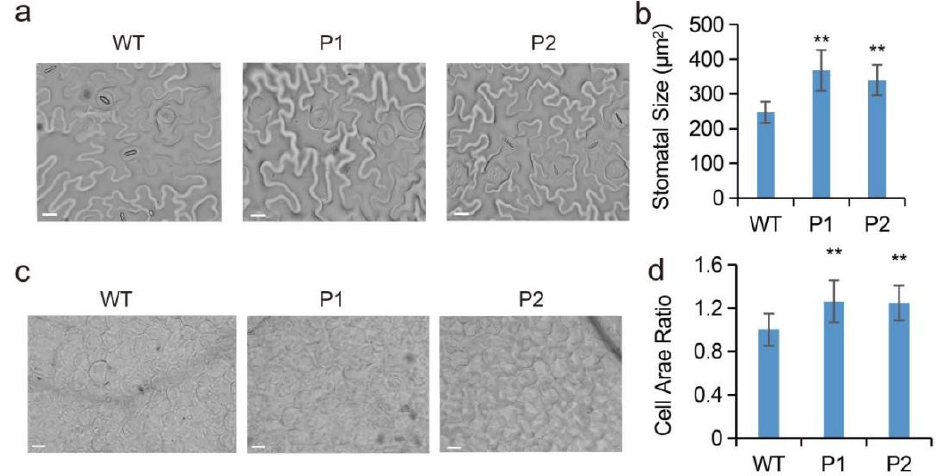
Figure 5. Effect of EuPIP1;1 on leaf cell size in Arabidopsis . ( a ) Stomata distribution in WT and transgenic lines (P1 and P2). Bar = 20 μm. ( b ) The stomatal size. ( c ) Palisade cells of the leaf from WT and transgenic lines (P1 and P2). Bar = 10 μm. ( d ) The cell area ratio. (** p < 0.01, one way ANOVA).